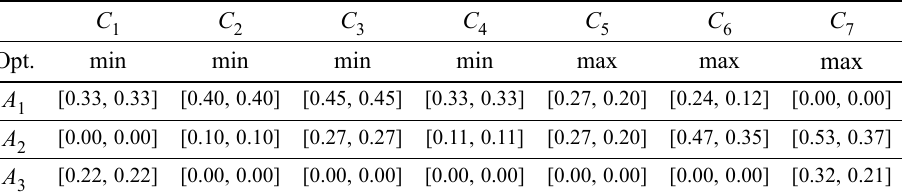
Table 8. Normalized grey decision matrix